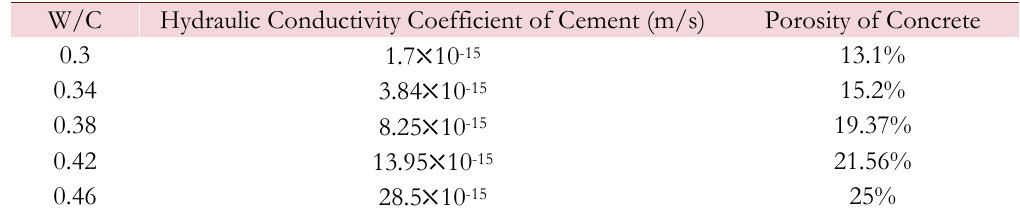
Table 4: Hydraulic conductivity coefficient and porosity of concrete in terms of water-cement ratio.